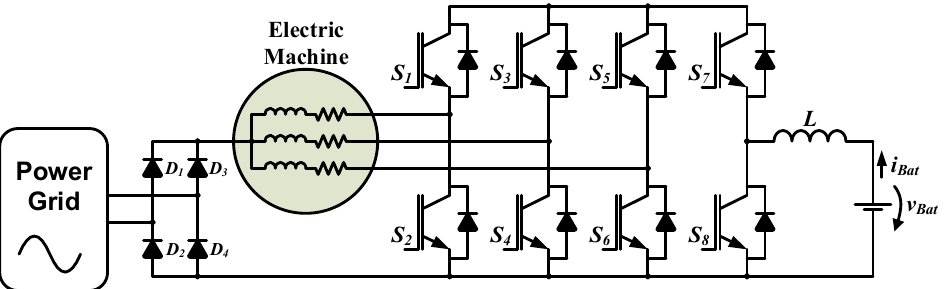
Figure 3. Non-isolated, single-phase unified power converter topology based on an electric machine with neutral point access [28].